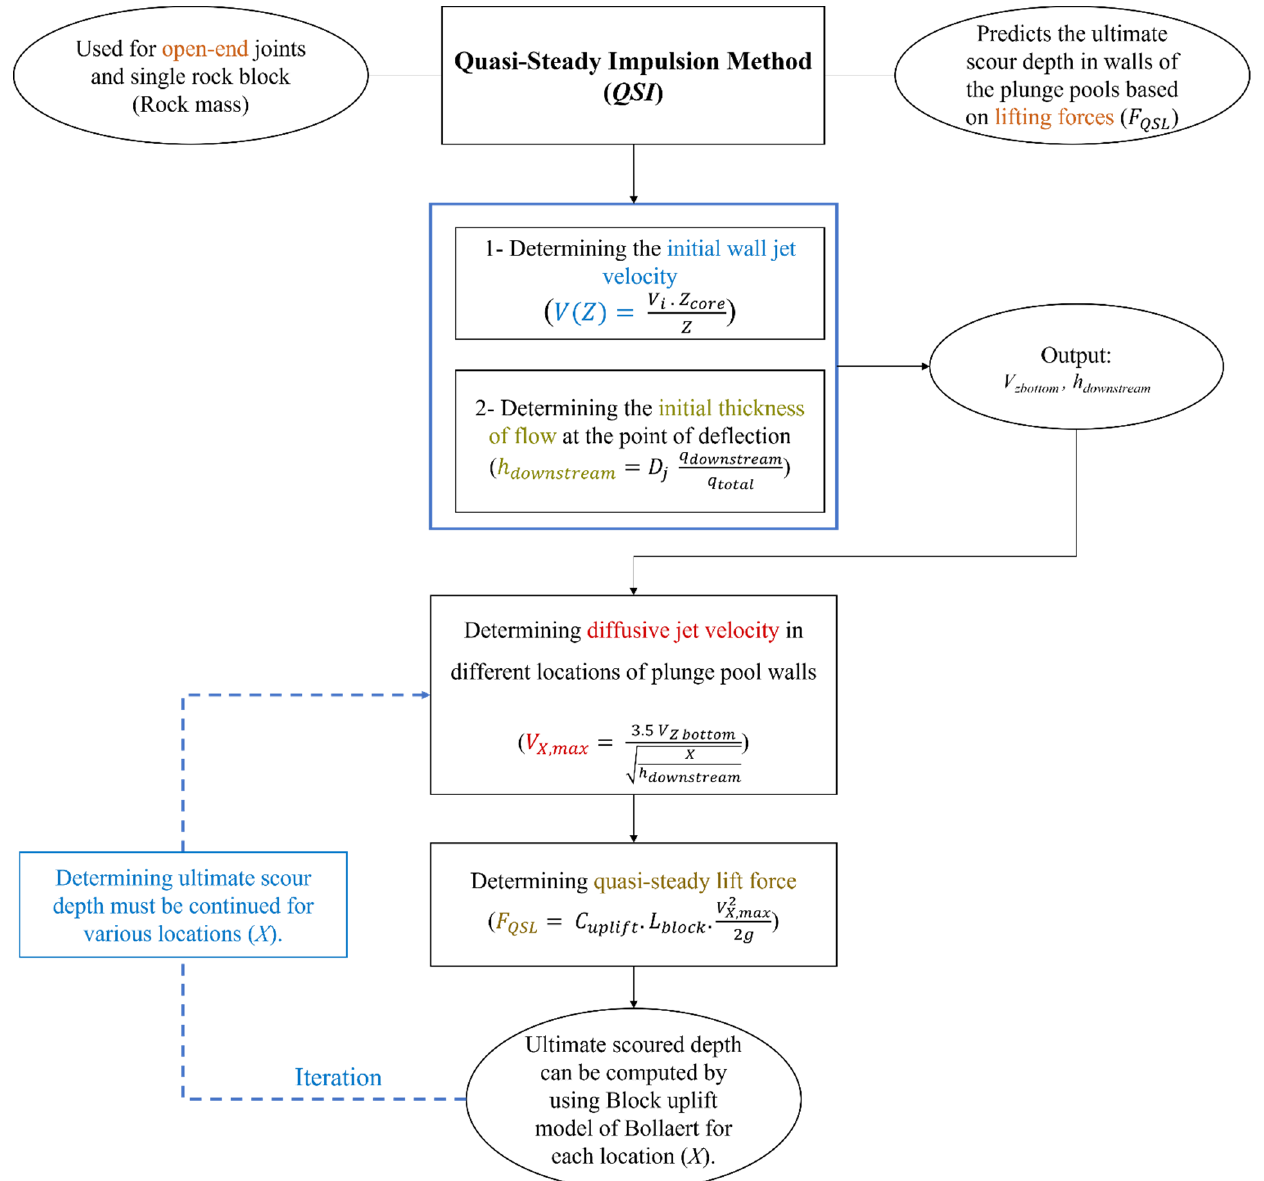
Figure 16. QSI flowchart.